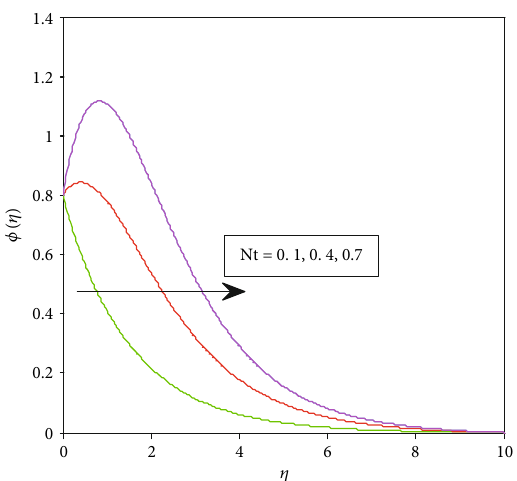
Figure 28: Concentration distribution for di ff erent values of the thermophoresis parameter.